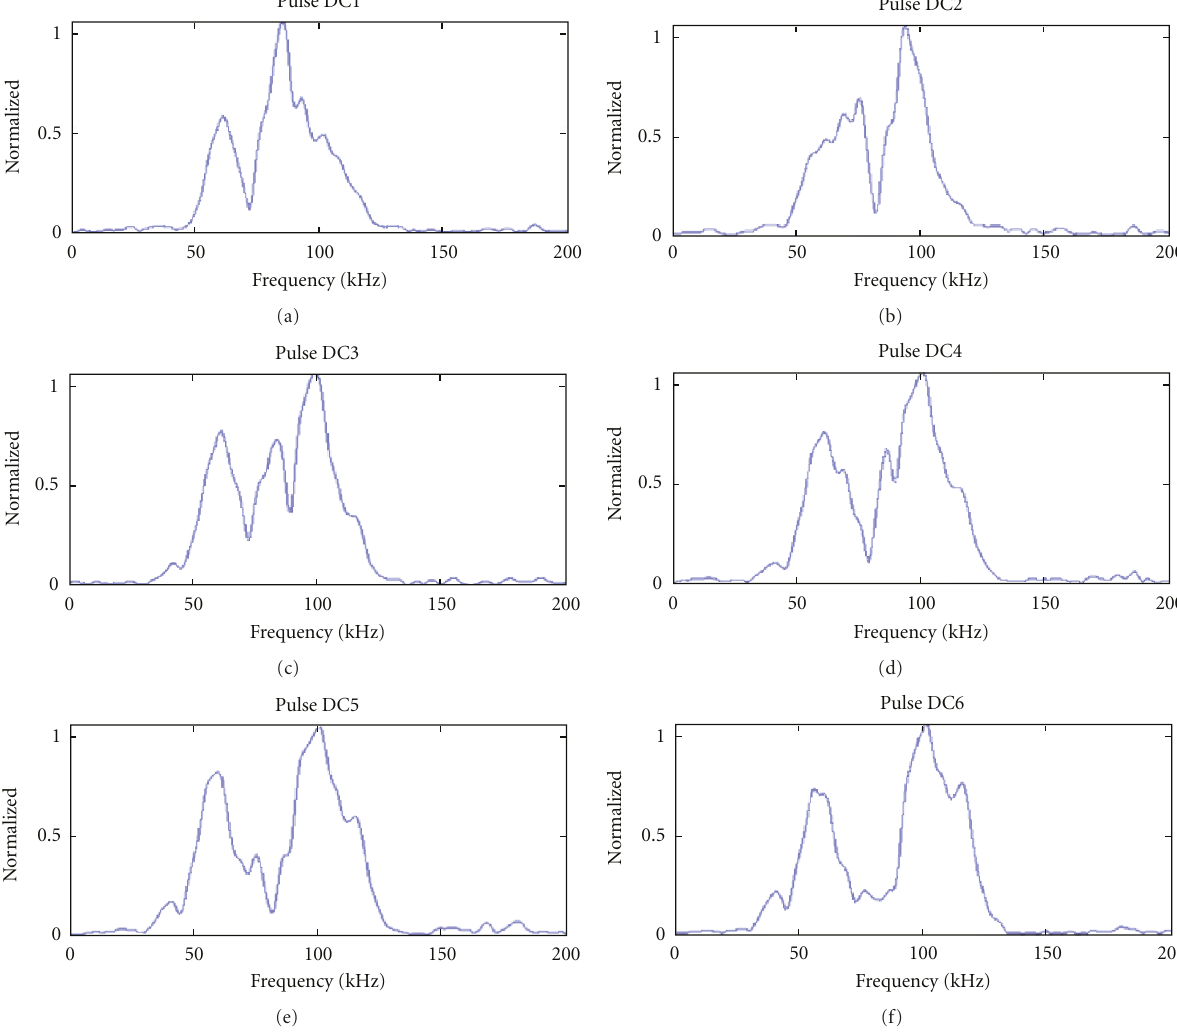
Figure 9: Spectral responses for SL17L cable D on coarse sand, 45 ◦ grazing angle,